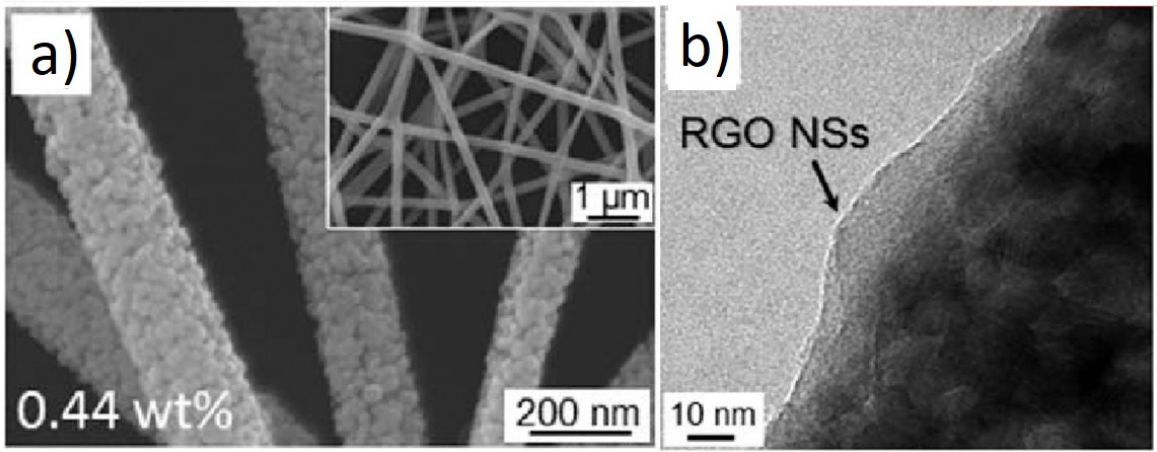
Figure 5. ( a ) SEM image and ( b ) TEM image of 0.44 wt.% rGO-loaded ZnO NFs [59].